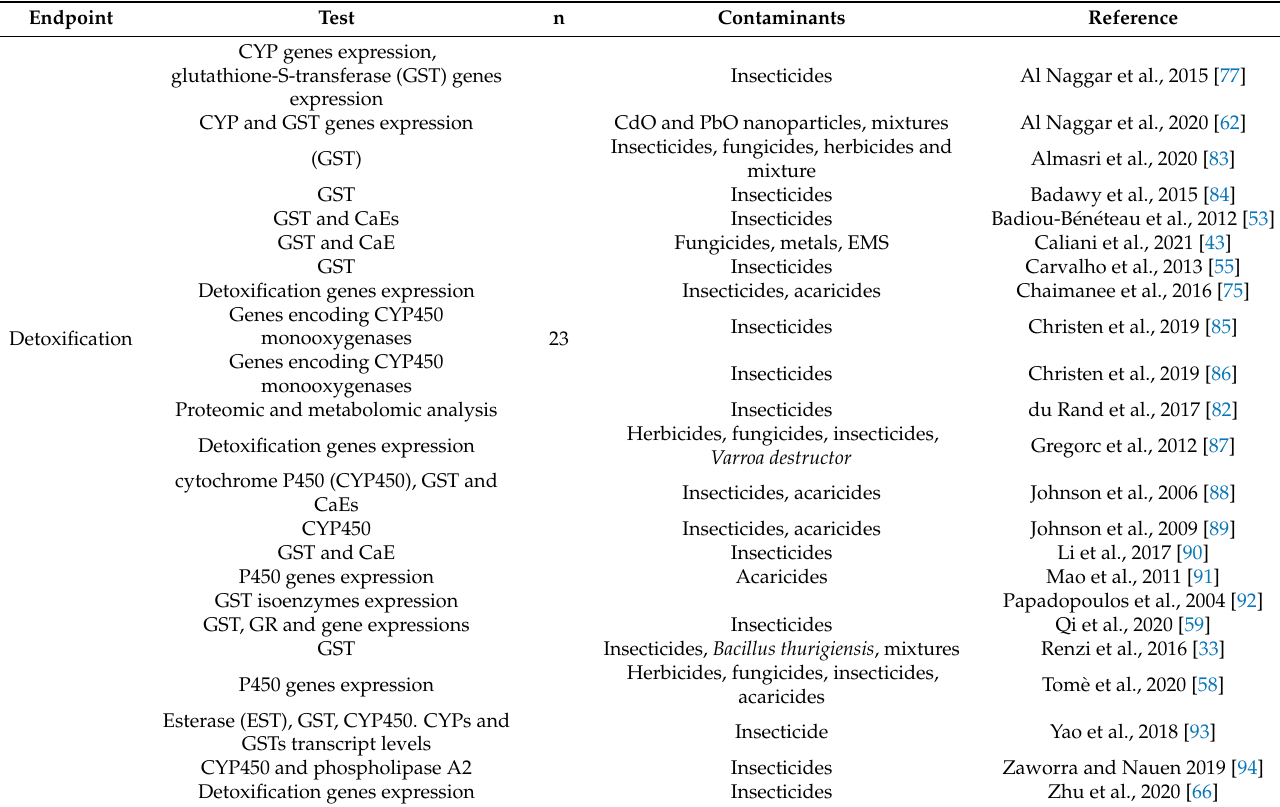
Table 2. Summary of laboratory studies divided by molecular and enzymatic endpoint and